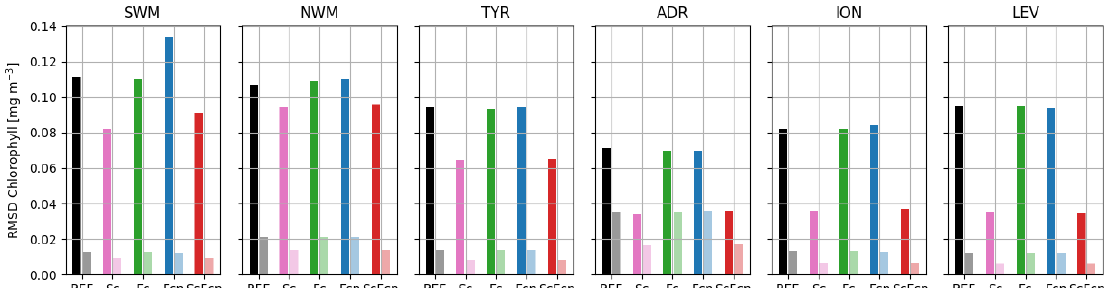
Figure 5. RMSD between model simulations and satellite chlorophyll observations in six sub-basins (Fig. 1) for winter (left and darker bars) and summer (right and lighter